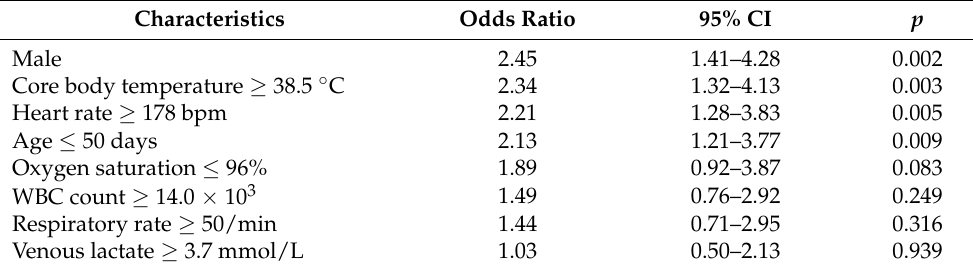
Table 4. Adjusted risk of serious